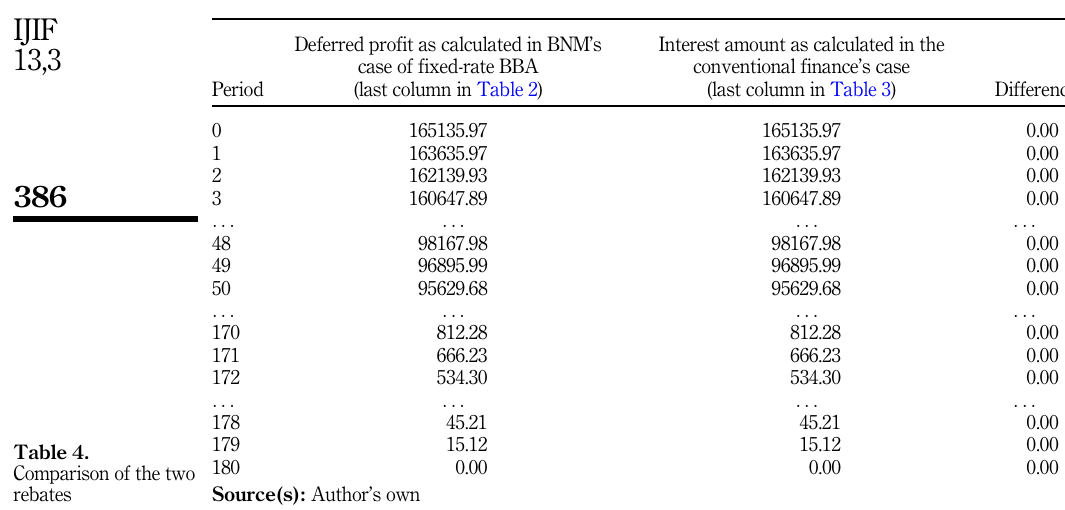
Table 4. Comparison of the